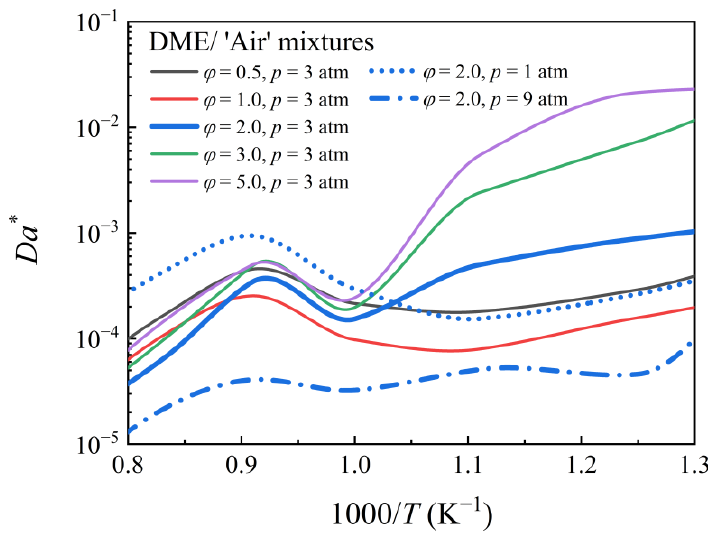
Figure 9. Da * of DME/‘air’ mixtures at various pressures and equivalence ratios.